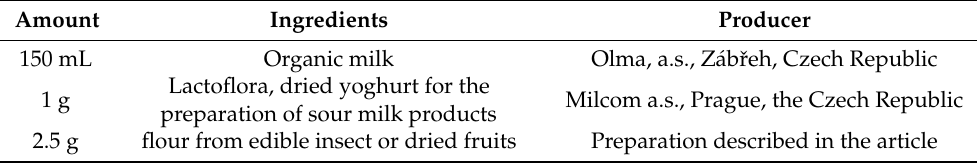
Table 4. Content of ingredients for tests monitoring the fermentation of baker’s